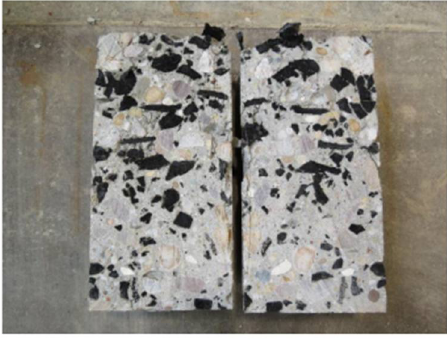
Figure 3. Crumb rubber concrete.